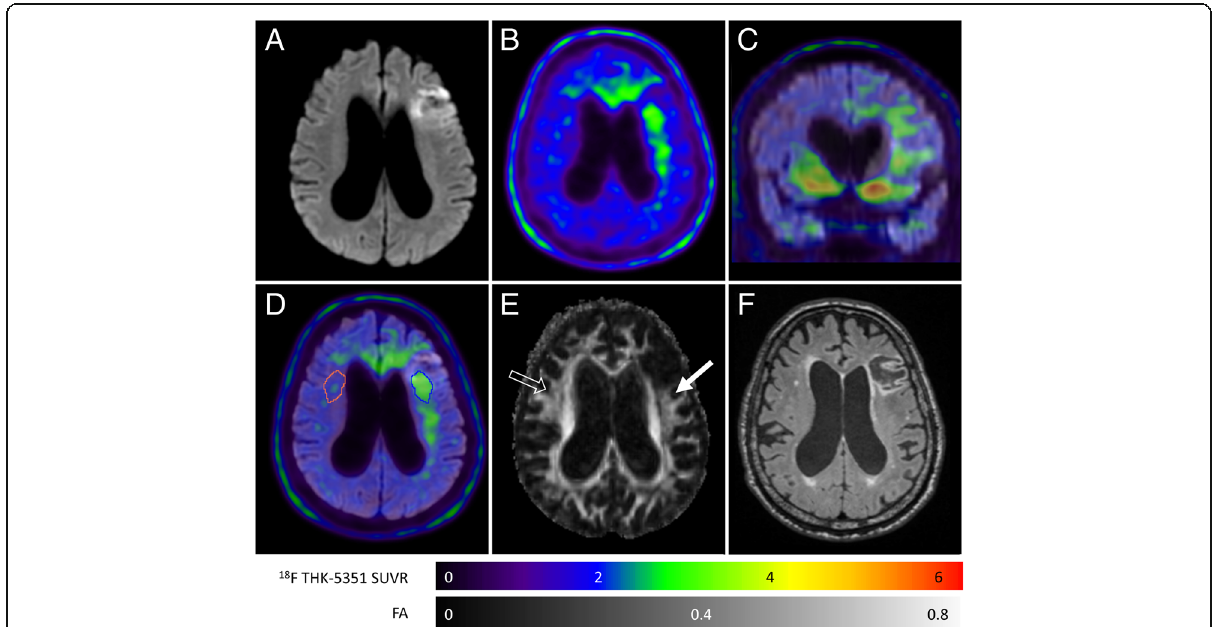
Fig. 2 Multi-modality imaging characteristics in the patient (case 5) with a left frontal cortical infarction on diffusion-weighted imaging (DWI) ( a ). Low 18 F-THK-5351 uptake is noted in the ischemic core, and high uptake is noted in the peri-ischemic area over the corona radiata, the genu of the corpus callosum, and in the bilateral frontal areas ( b , c ). The ROI for 18 F-THK-5351 retention is drawn in the peri-ischemic area, and a mirrored ROI is placed in the contralateral hemisphere as the control ( d ). There is a decreased fractional anisotropy (FA) on diffusion tensor imaging ( e ) (filled arrow) in the peri-ischemic area with increased 18 F-THK-5351 retention as compared to the contralateral side (empty arrow). No corresponding white matter change is noted on the follow-up FLAIR image ( f )